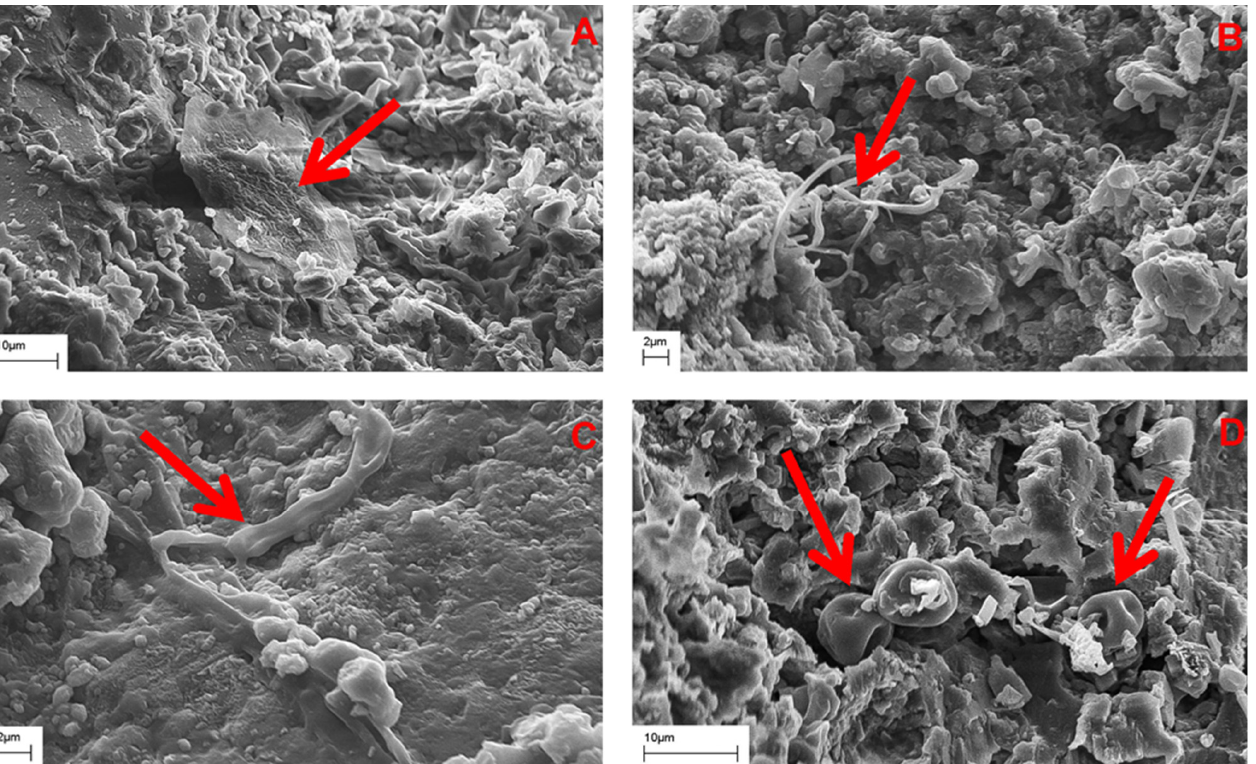
Figure 16. SEM images showing: ( A )—microbial biofilm (test site 1), ( B )—actinobacteria-like cells (test site 4), ( C )—fungi (test site 4), and ( D )—epilithic cyanobacterial cells embedded with secondary calcite (test site 5) observed on the surface of the weathering rinds from all test sites (Hallstätter Glacier foreland); arrows indicate microbial cells.